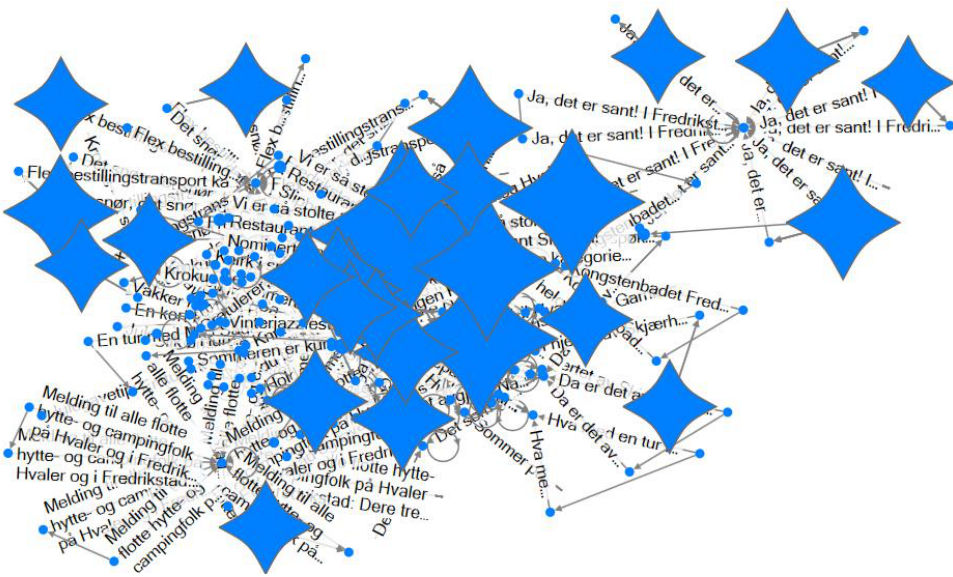
Figure 4. Visualization of the online conversations using a grouping